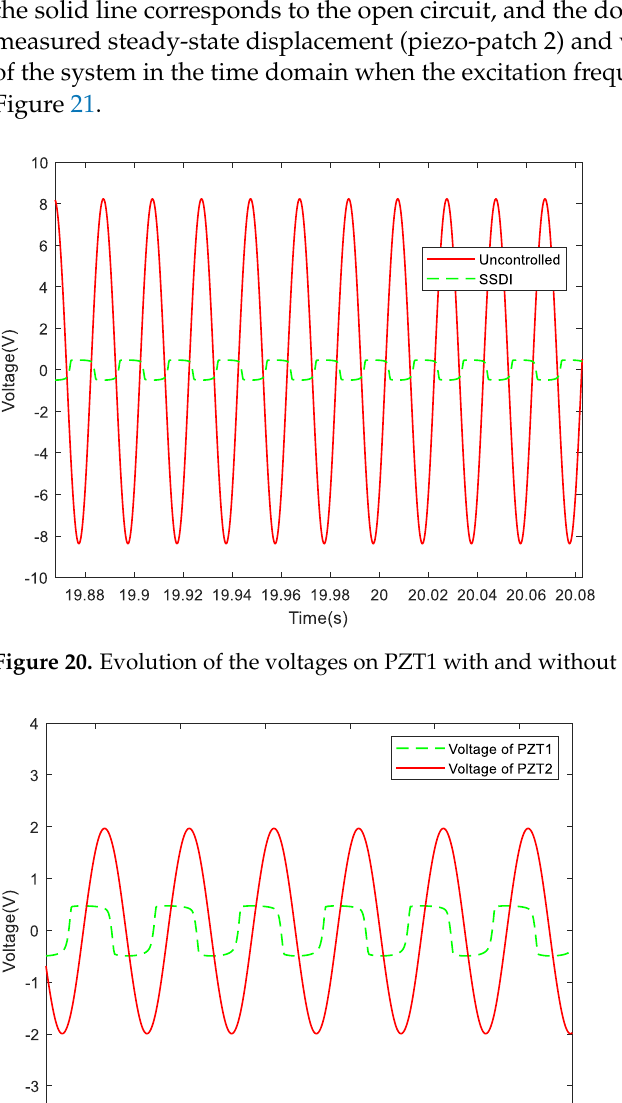
Figure 19. Sweeping frequency waterfall.